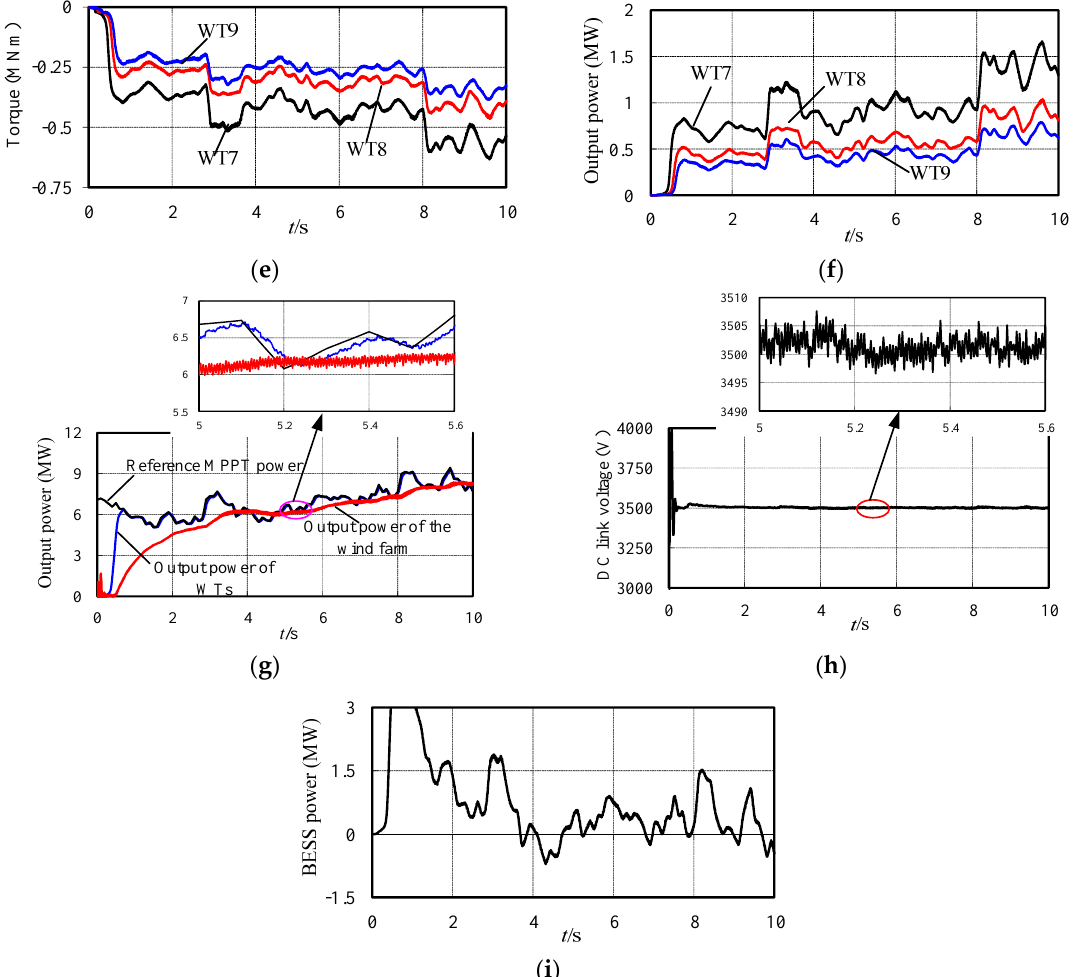
Figure 10. Time histories of the torque, power of WTs in the wind farm under the maximum power point tracking (MPPT) operation mode. ( a ) Torque of the first group WTs (1–3). ( b ) Torque of the second group WTs (4–6). ( c ) Torque of the third group WTs (7–9). ( d ) Output power of the first group WTs (1–3). ( e ) Output power of the second group WTs (4–6). ( f ) Output power of the third group WTs (7–9). ( g ) Total output power. ( h ) DC link voltage. ( i ) Power of the BESS.